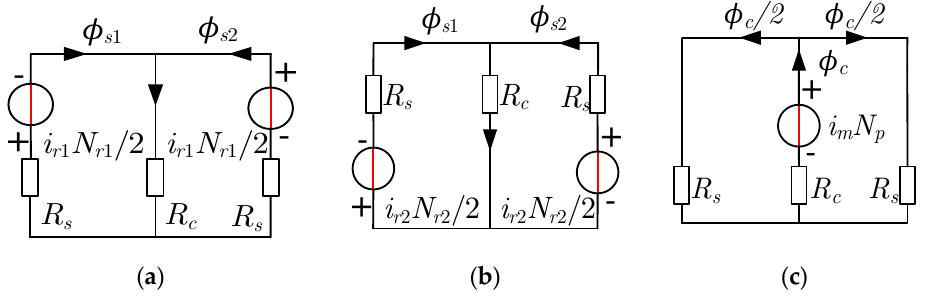
Figure 5. Equivalent magnetic circuit with the excitation of: ( a ) i r 1 ; ( b ) i r 2 ; ( c ) i m . Derivation of L r 1 , L r 2 , L m , M 1 m and M 2